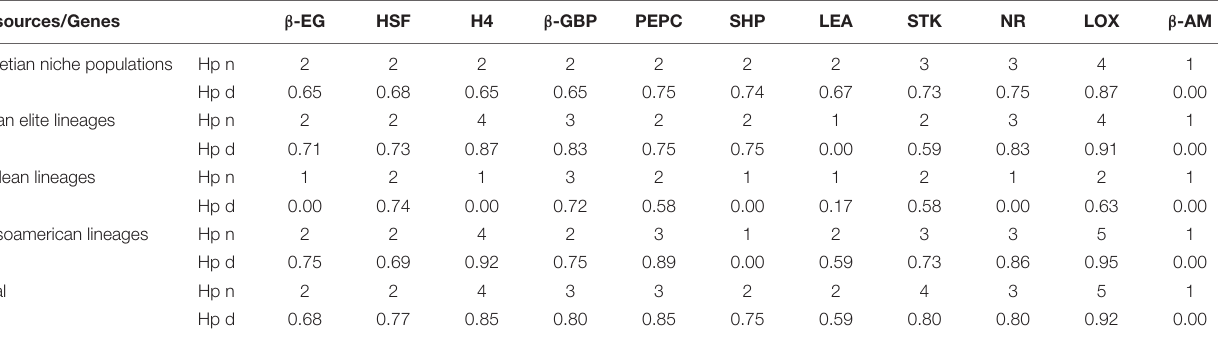
TABLE 6 | Relative haplotype number (Hp n) and haplotype distance (Hp d) (Nei, 1987) of the SNP-derived allele variants found in the core collection for each of the 11 target genes and for each of the four identified clusters, based on accession identity (farmer populations and breeder selections) or ancestry identity (Andean and Mesoamerican), and in